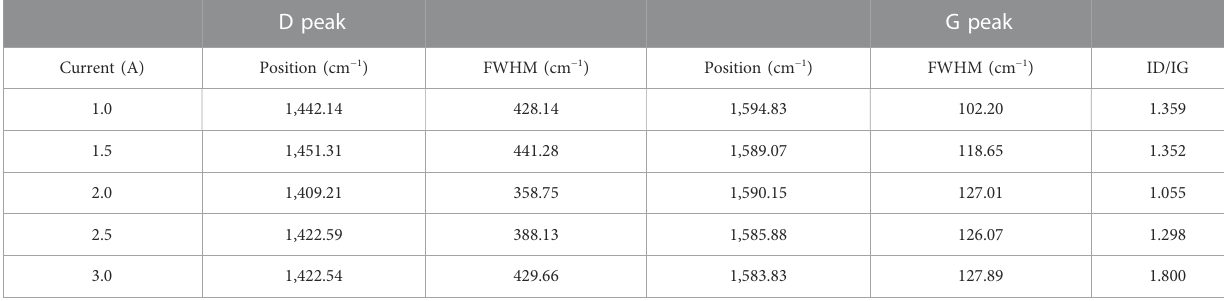
TABLE 2 The position, FHWM of the D peak and G peak, and I D /I G ratio of PI substrates treated with different sputtering currents. D peak G peak Current